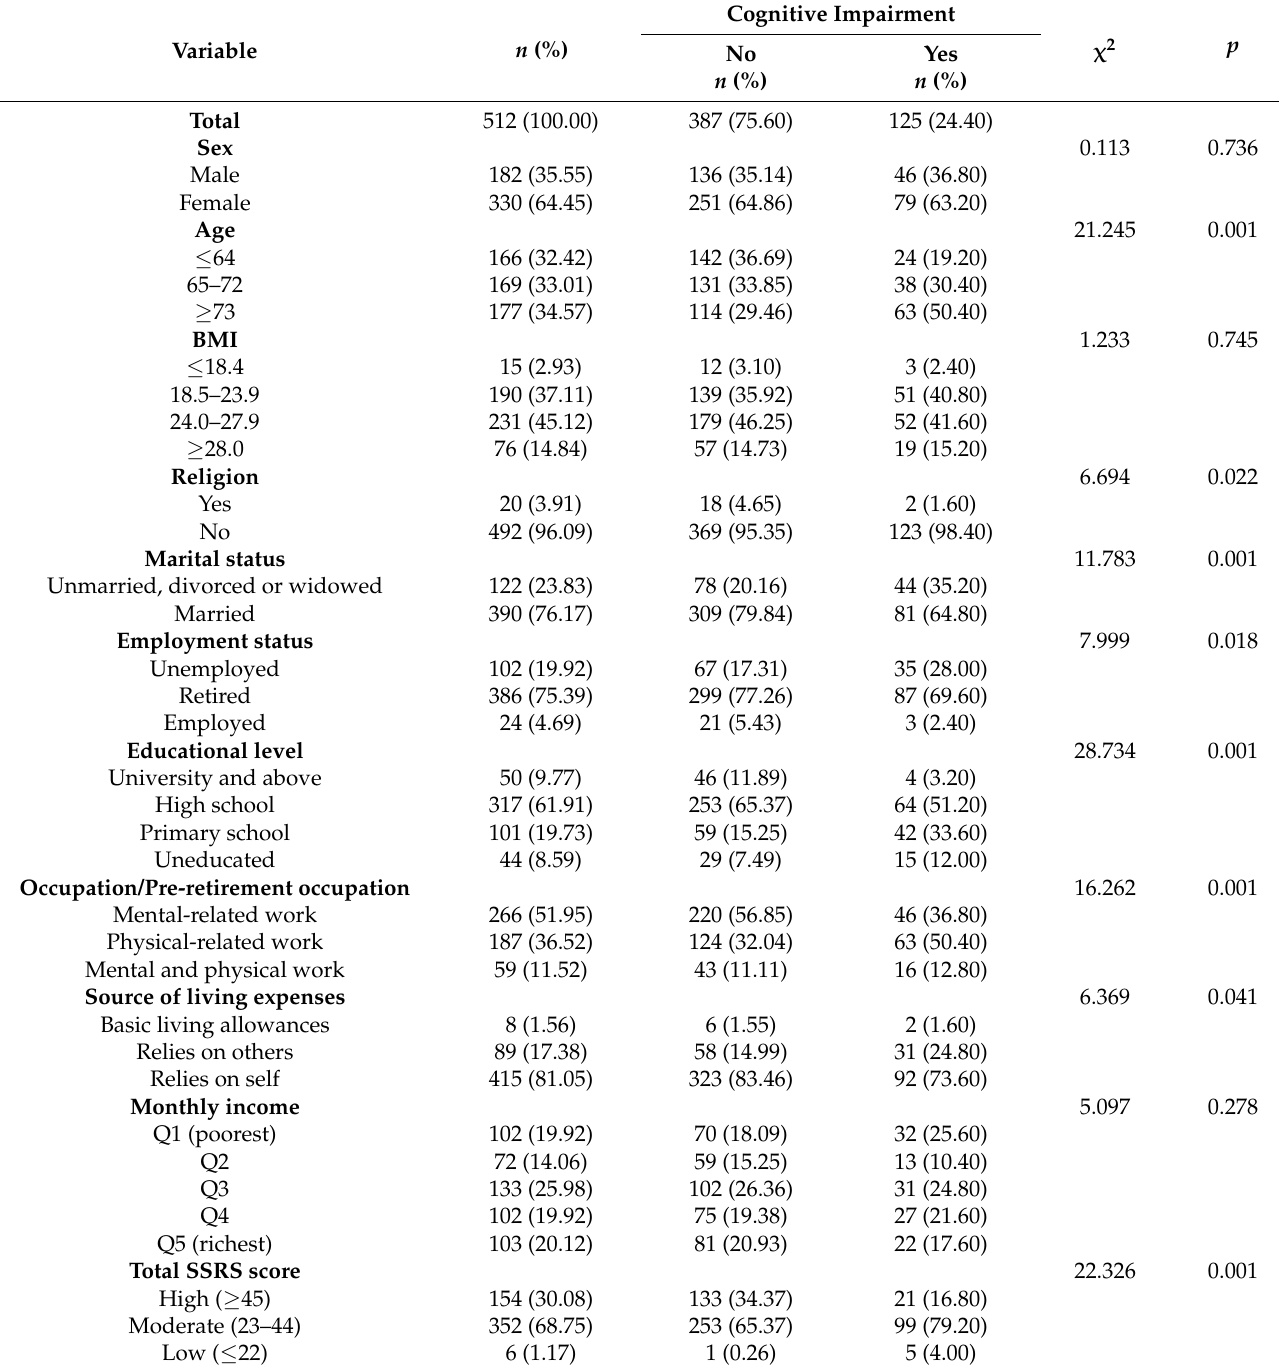
Table 1. Socio-demographic characteristics and social support of the elderly in Jinan,